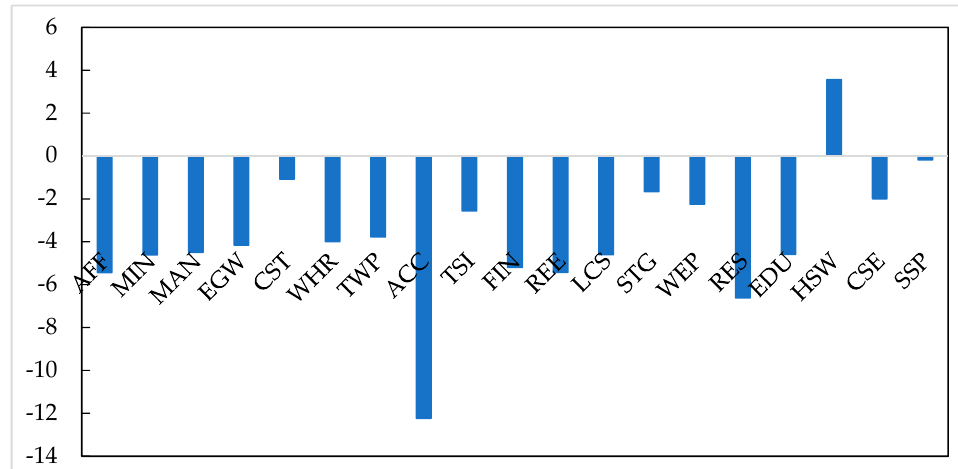
Figure 5. The impact of the COVID-19 pandemic on the output value of aggregated sectors (%). Source: CHINAGEM model.